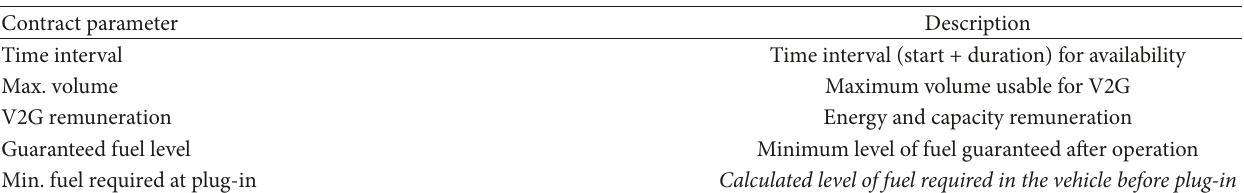
Table 2: Volume-based contract parameters.